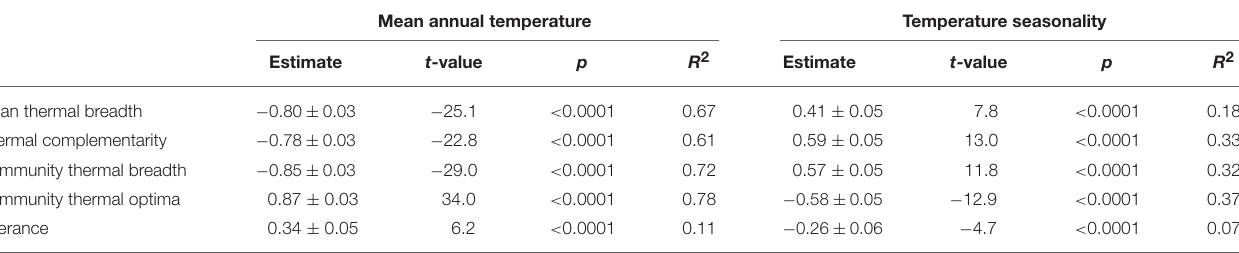
TABLE 1 | Statistical output for the generalized least squares models of the effects of the temperature gradients on community thermal breadth, thermal complementarity, mean thermal breadth, community thermal optima, and tolerance.